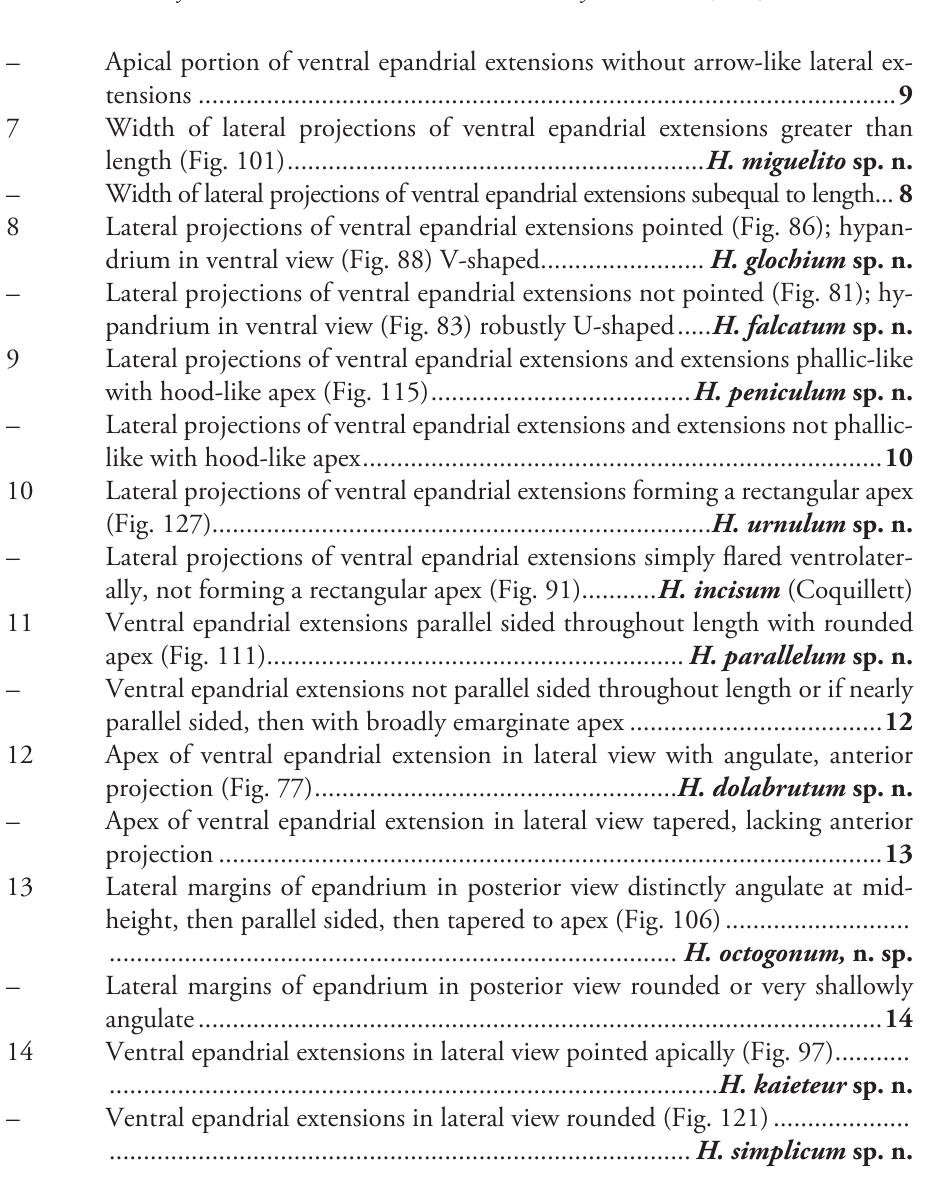
Diagnosis. This species is distinguished from congeners by the following combination of characters: Small shore flies, body length 1.15–1.70 mm. Head: Antenna